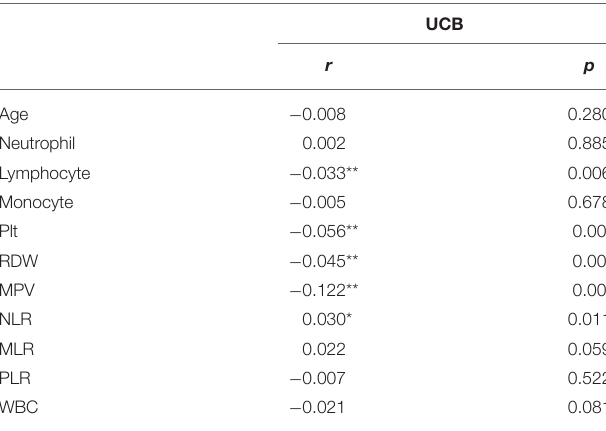
TABLE 2 | Correlations between bilirubin and peripheral biomarkers of inflammation derived from CBC in schizophrenia.